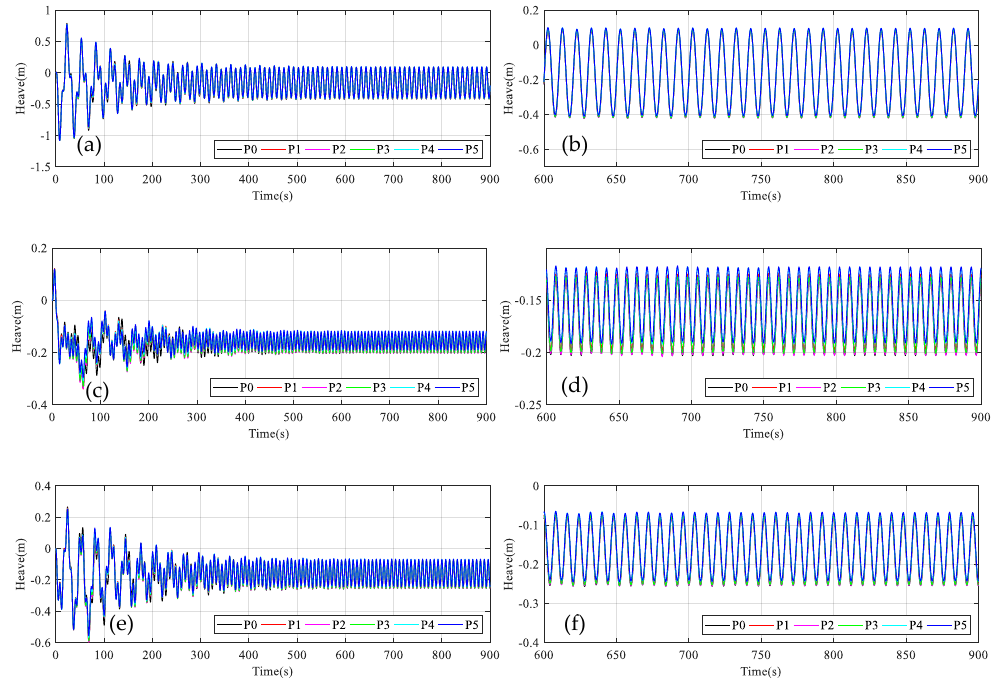
Figure 6. Heave motion from 0 s to 900 s for ( a ) case 1, ( c ) case 2, and ( e ) case 3, and from 600 s to 900 s for ( b ) case 1, ( d ) case 2, and ( f ) case 3.